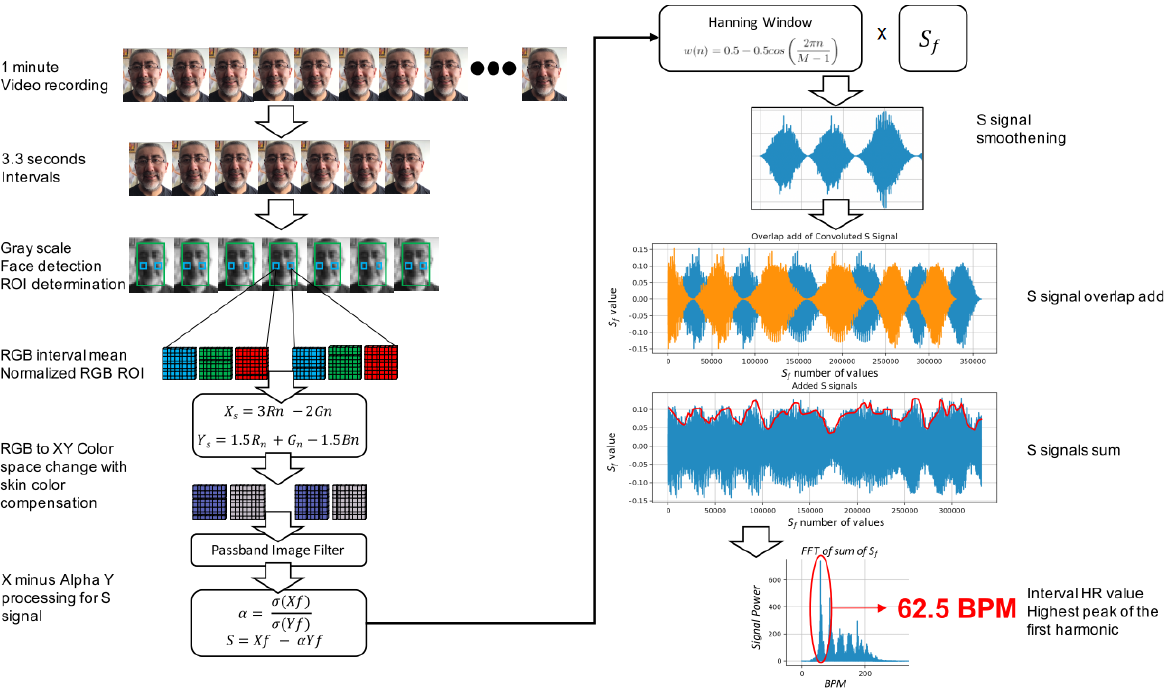
Figure 2. Chroma-based rPPG was used to calculate the HR values using ROI extracted from video recordings of students’ faces.